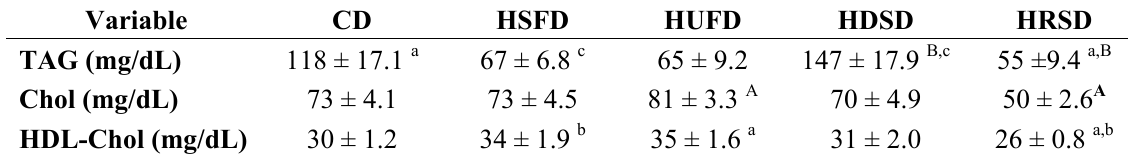
Table 4. Effects of experimental diets on serum lipids.